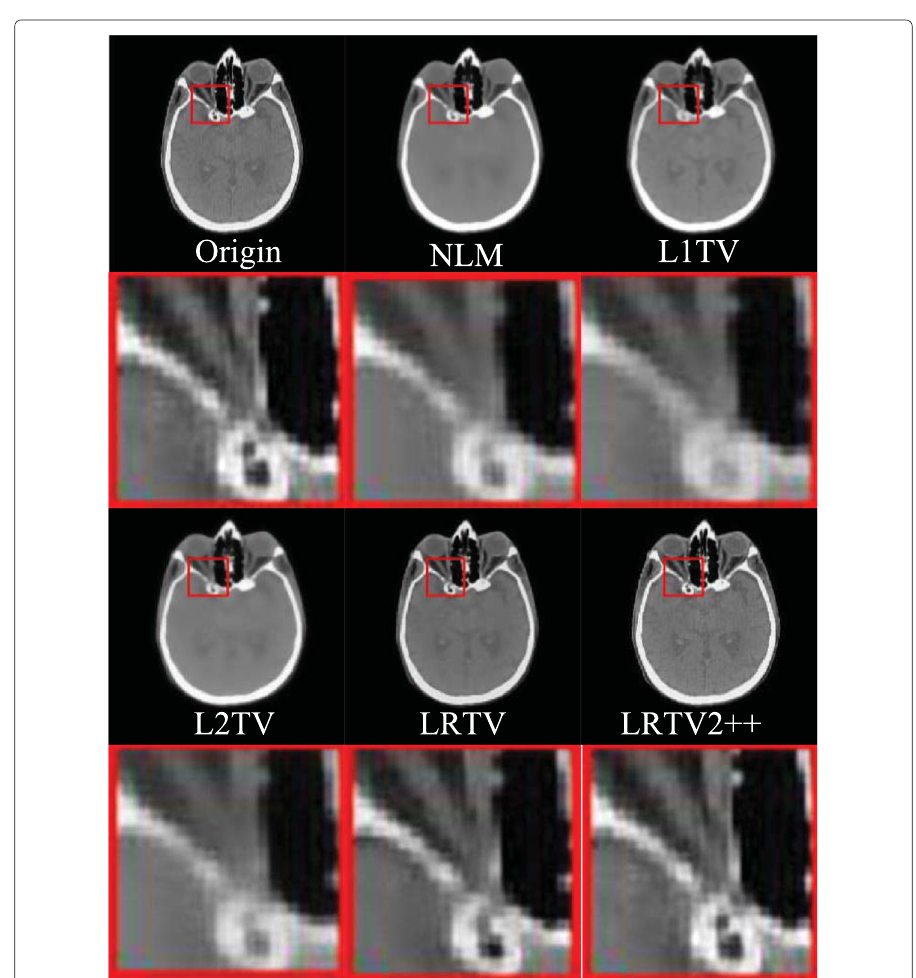
Fig. 5 The performance of recovered images of different methods and enlarged regions(HEADNECK)